Question: What visual encoding does this figure use to show its data?
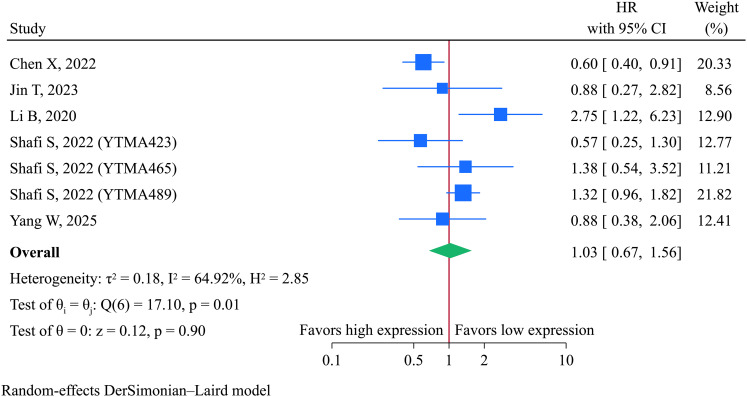
Answer: forest